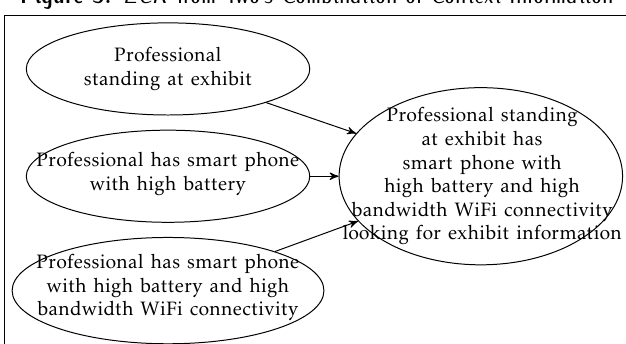
Algorithm 2: Formation of Essential Context-derived Reasons